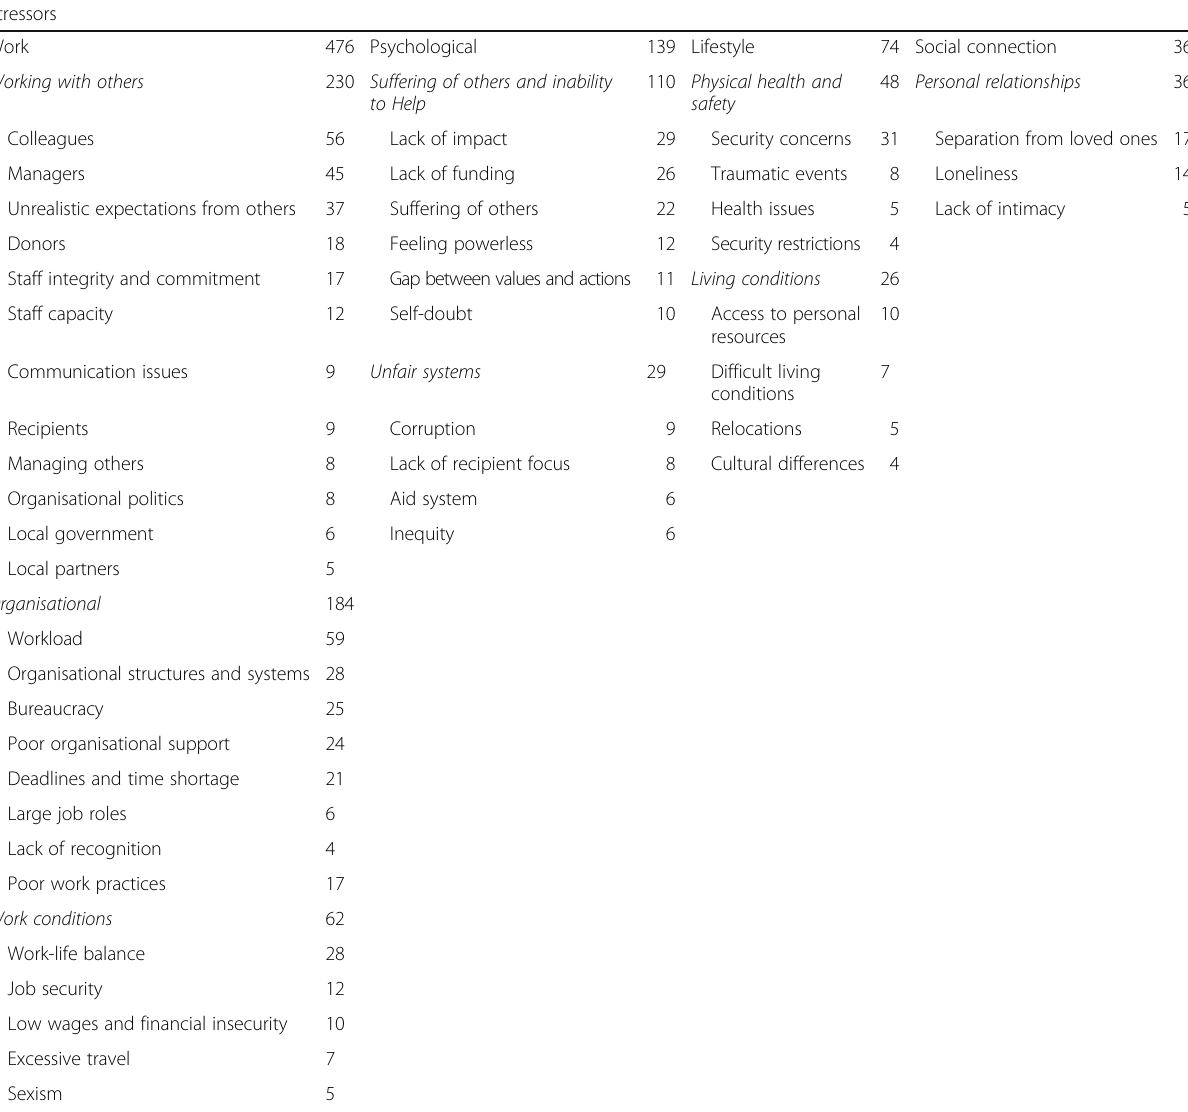
Table 1 Stressor code and sub-theme frequency grouped by four overarching themes Stressors